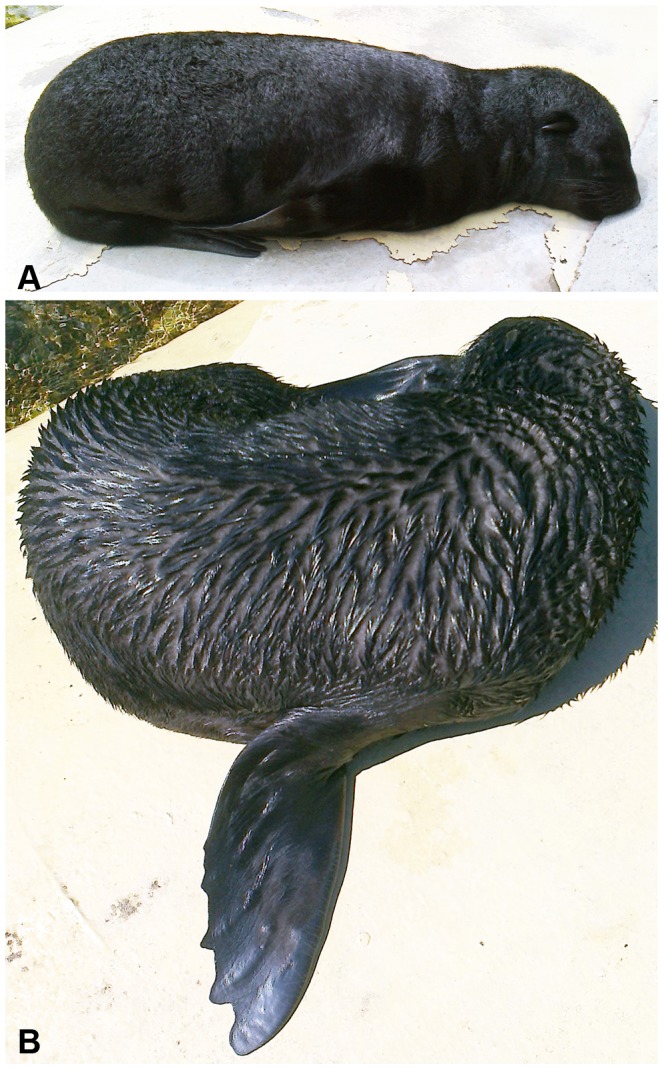
Fur seal pups hauling out with dry and wet fur.(A) Pup with dry fur. The hairs are curled, but constitute a continuous surface. (B) Pup with wet fur, 5 min after leaving the water. The guard hair is divided into strands, opening gaps through which the light grey under fur is visible.